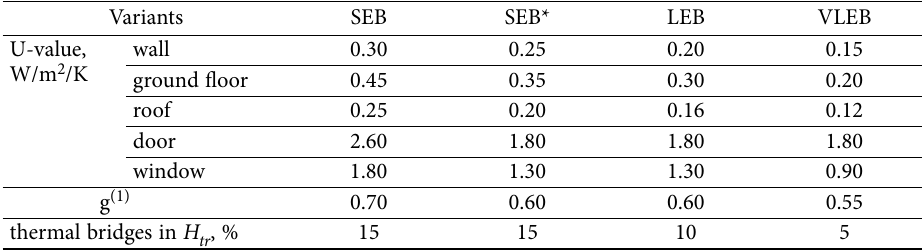
Table 2. The heat transfer coefficient of building envelopes, the share of thermal bridges depending on the energy standard Variants SEB SEB* LEB VLEB U-value, wall 0.30 0.25 0.20 W/m 2 /K ground floor